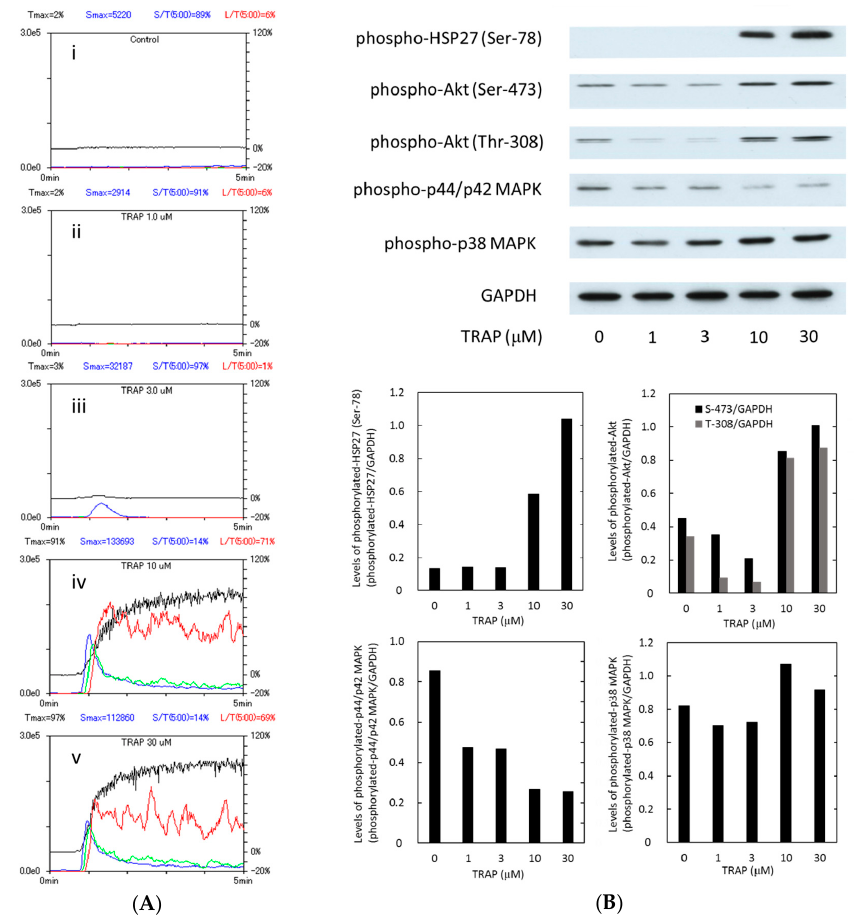
Figure 1. Representative patterns of platelet aggregation induced by thrombin receptor-activating protein (TRAP) as detected by an aggregometer using laser-scattering system and representative data showing the TRAP-induced HSP27 phosphorylation in platelets from type 2 diabetes mellitus (DM) patients. Platelet-rich plasma (PRP) from type 2 DM patients was stimulated by TRAP (0, 1.0, 3.0, 10 and 30 µM) in an aggregometer at 37 °C for 4 min with a stirring speed of 800 rpm. ( A ) time-dependent changes in the platelet aggregation after stimulation by 0 µM (i); 1.0 µM (ii); 3.0 µM (iii); 10 µM (iv) and 30 µM (v) are shown. The black line indicates the percentage of transmittance of each sample (the isolated platelets were recorded as 0%, and platelet free plasma was recorded as 100%). The blue line indicates small aggregates (9–25 µM); green line, medium aggregates (25–50 µm); red line, large aggregates (50–70 µM); ( B ) the reaction was terminated by the addition of an ice-cold EDTA (10 mM) solution. The lysates of platelets were subjected to a Western blot analysis making use of antibodies against phospho-specific HSP27 (Ser-78 and Ser-82), phospho-specific Akt (Ser-473 and Thr-308), phospho-specific p44/p42 mitogen-activated protein (MAP) kinase, phospho-specific p38 MAP kinase and GAPDH. The bands were quantified using the ImageJ software program (National Institutes of Health, Bethesda, MD, USA) as the counts of pixels. The bands of phospho-HSP27, phospho-Akt, phospho-p44/p42 MAP kinase and phospho-p38 MAP kinase were normalized to the GAPDH bands. The ratio is presented for each value. The upper panel indicates the results of a Western blot analysis, and lower panels indicate each ratio.